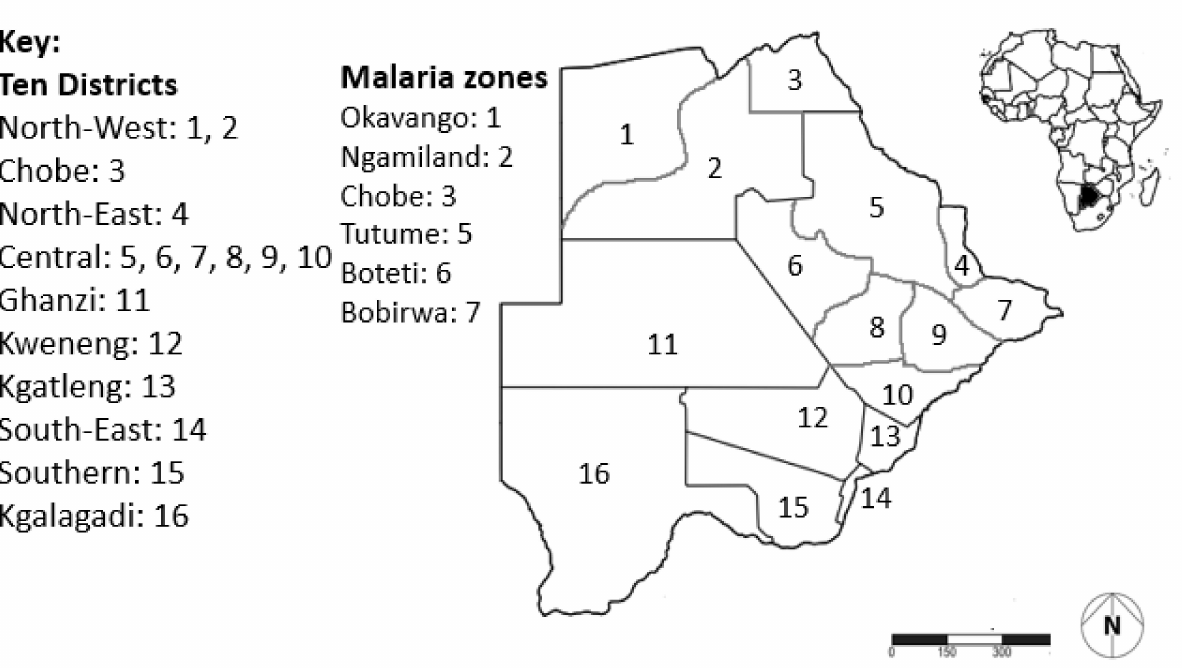
Figure 1. A map of Botswana showing all 10 districts across the country from which respondents were interviewed telephonically. The confirmed malaria cases per 1000 population range from 0 (4, 8, 13, 16), 0–0.1 (10, 12), 0.1–1 (5, 6, 9, 15), 1–10 (2, 3, 7, 11) and 10–50 (1) in keeping with Bango et al. [16] and Kgoroebutswe et al. [70]. The national mosquito vector programme is currently deployed as Main (Indoor Residual Spraying; 1, 2, 3, 5, 6, 7) and supplementary interventions with Long lasting Insecticide treated Nets (1, 2, 3, 5, 6, 7) and piloted Larviciding (5, 6, 7) [70]. The level of knowledge on mosquito bio-ecology and associated diseases has been assessed at 1, 7, 8 and 9